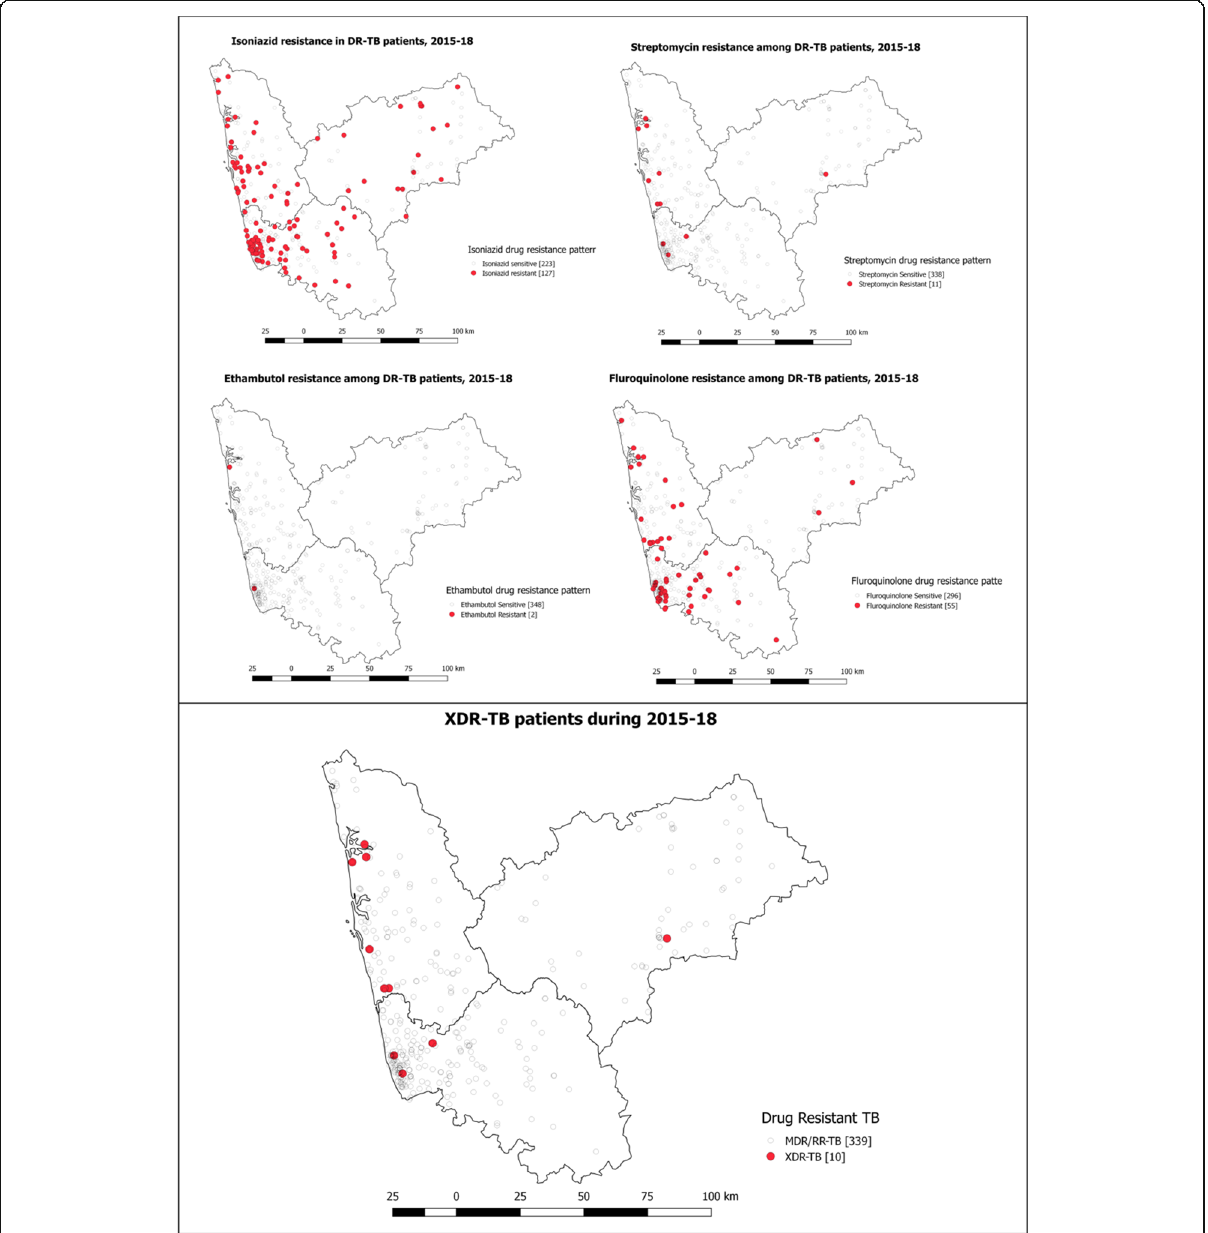
Fig. 5 Spatial pattern of drug-resistant pattern of DR-TB patients notified during 2015 to 2018 in three selected districts of Karnataka, South